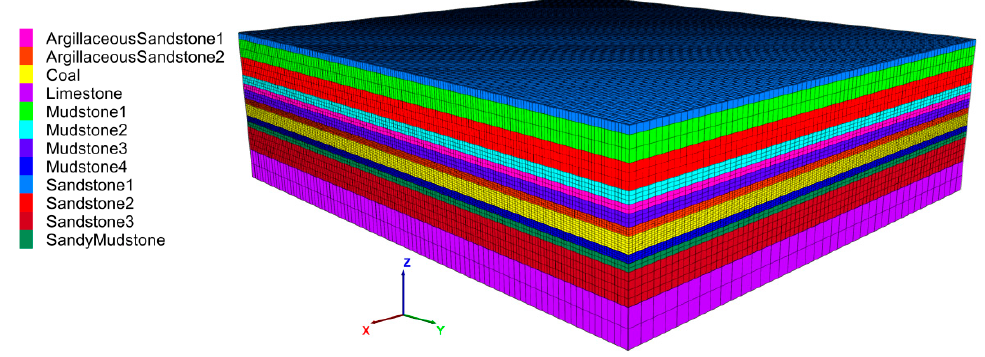
Figure 10. Numerical model of the strata. Table 6. Model parameters of the strata.